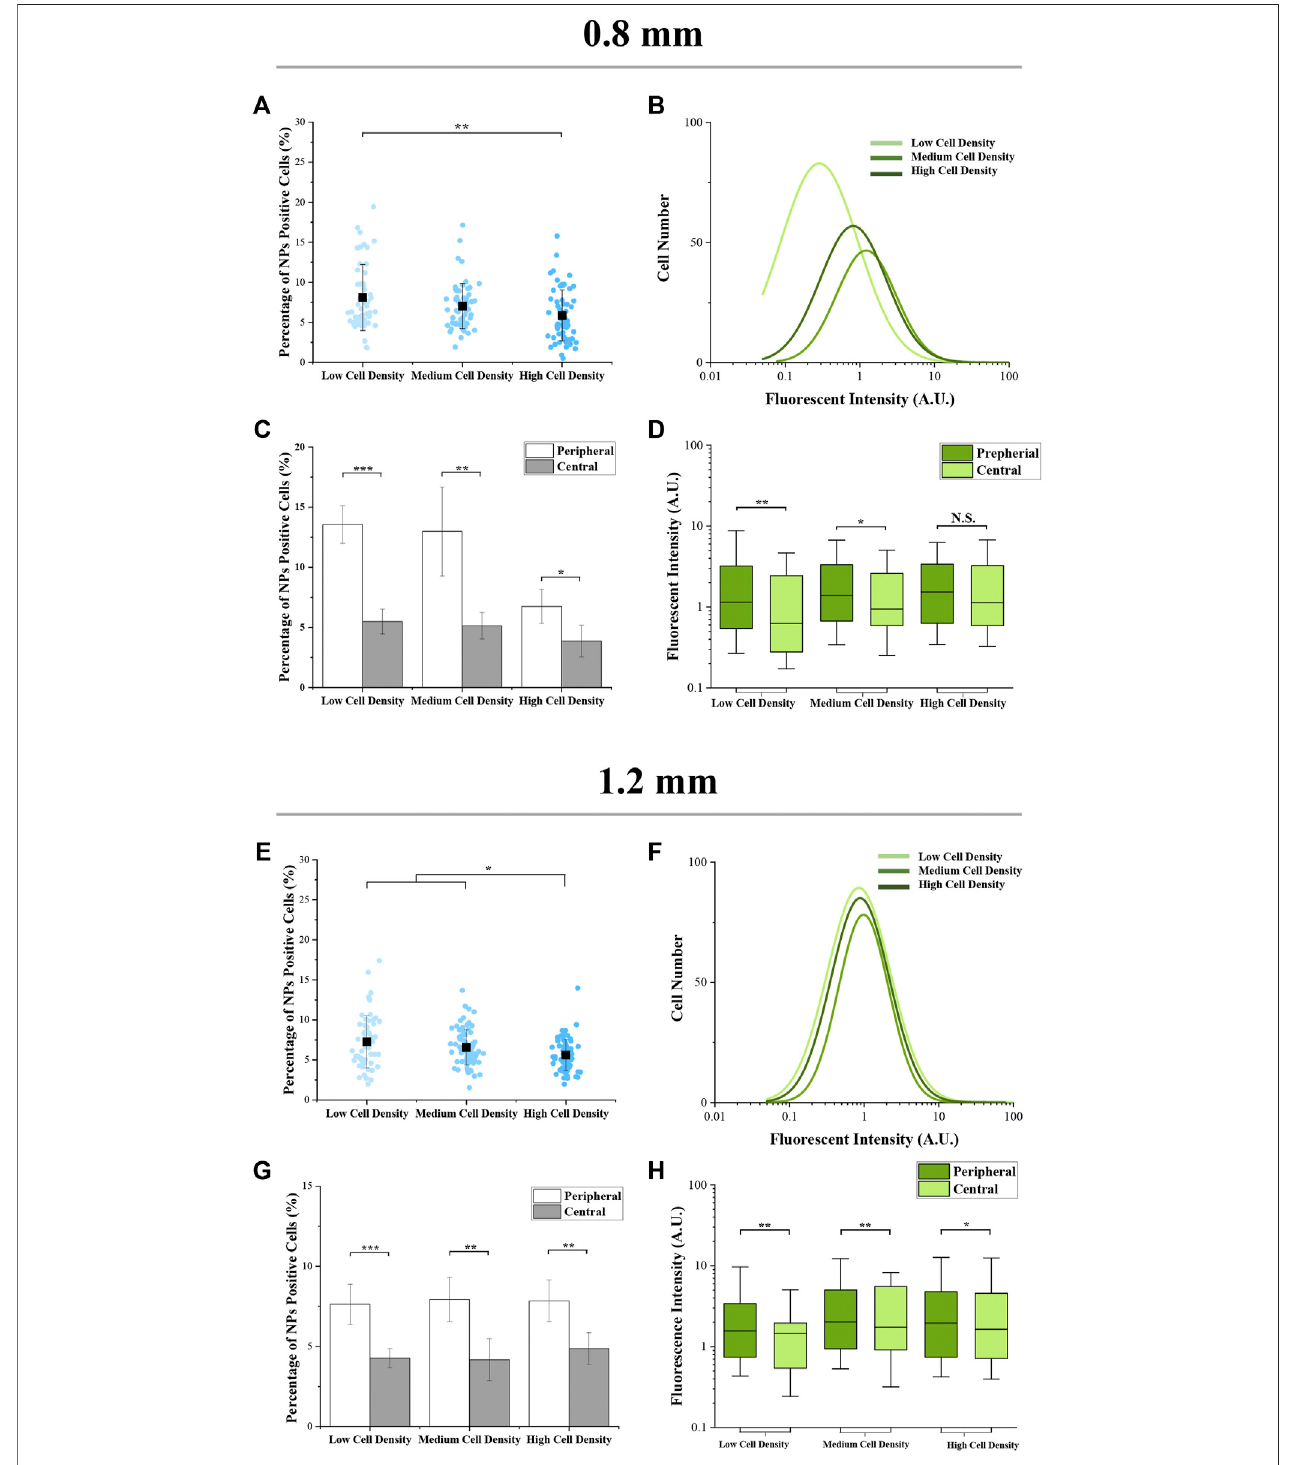
FIGURE 4 | Cellular uptake capacity of micropatterned colonies with different regions. (A,E) Percentage of NP-positive cells within whole colonies. Data are presentedasmeans±SDs(n > 30). (B,F) DistributioncurvesofNP-positivecells ’ intensity(n > 3,000). (C,G) PercentageofNP-positivecellsattheperipheralandcentral regions. Data are presented as means ± SDs ( n = 5). (D,H) Fluorescence intensity of NP-positive cells at the peripheral and central regions. Data are presented as means ± SDs (n > 100). * p < 0.05, ** p < 0.01, *** p < 0.001.